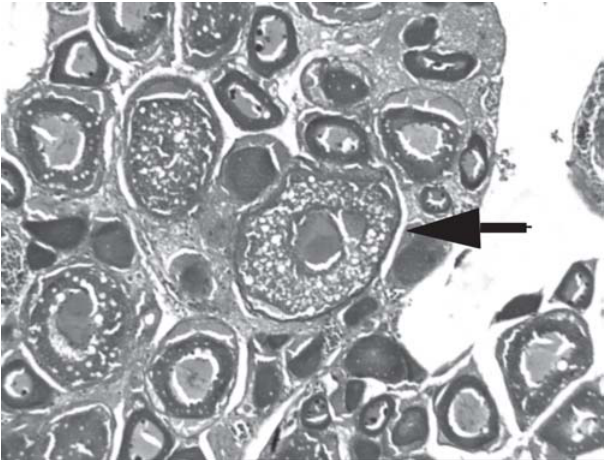
Fig. 4. Merluccius hubbsi: oocyte in cortical alveolar stage (arrow) (1.5mm length field).